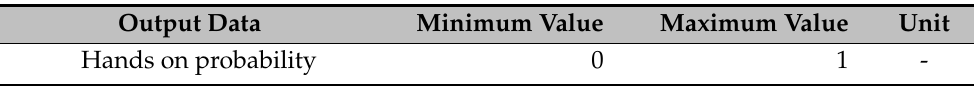
Table 3. Output data of a deep learning